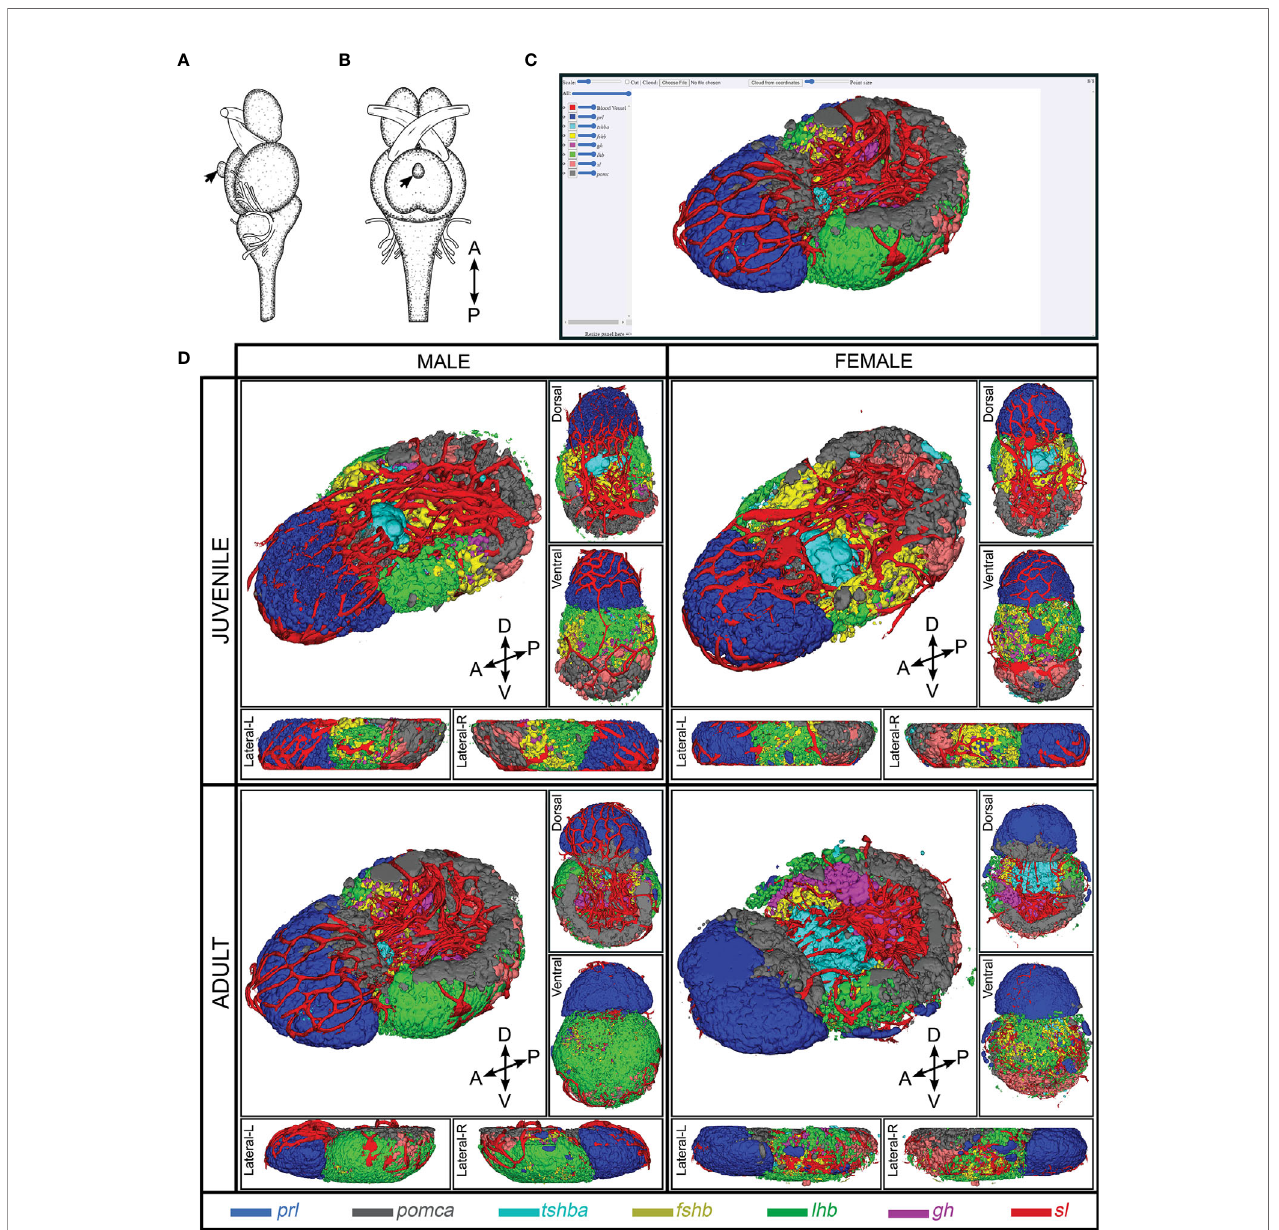
FIGURE 1 | 3D reconstruction of medaka anterior pituitary containing seven endocrine cell populations and blood vessel. Illustration of brain and pituitary (marked by black arrow) of medaka from lateral view (A) and ventral view (B) [Figure is adopted and modi fi ed with permission from (41)]. The navigation platform of 3D spatial distribution of endocrine cell populations that are now available online (C) . Snapshots of 3D reconstruction of endocrine cell populations from juvenile and adult medaka male and female (D) . Snapshots of 3D representations of the pituitary atlas captured from different perspectives: lateral (L, left; R, right), dorsal, and ventral. Four direction arrows display the direction of the pituitary (A, anterior; P, posterior; D, dorsal; V, ventral). The legend shows the color code for each cell